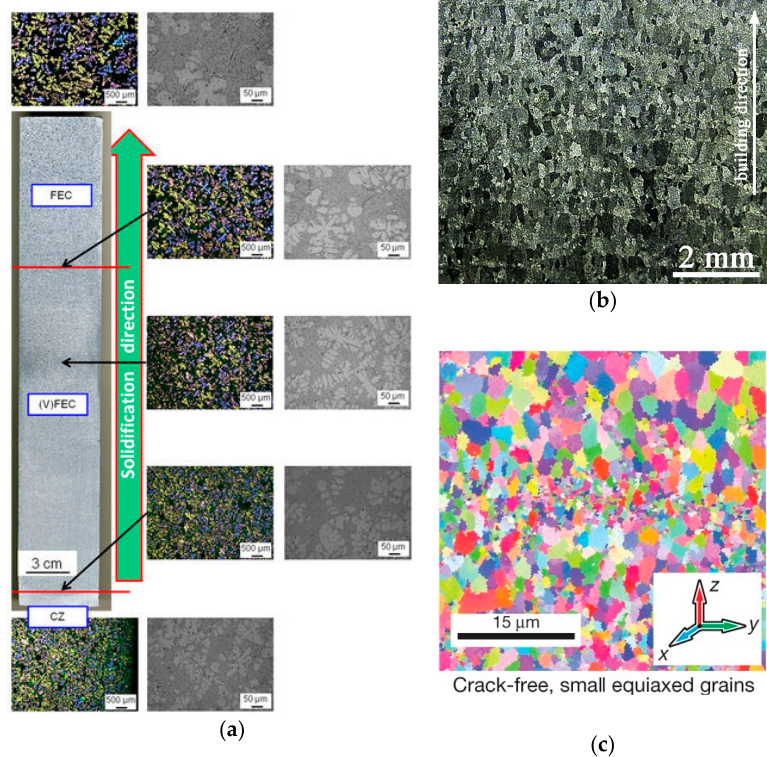
Figure 3. ( a ) Microstructure of the directionally solidified Al-10Si alloy with inoculation of Nb-based heterogeneous nuclei. CZ: chilled zone, (V) FEC: (very) fine equiaxed crystals. Adapted from Bolzoni [16]; ( b ) Optical micrographs showing fine near-equiaxed grains on the transverse cross section of the thick-plate titanium component produced by direct energy deposition (DED) at laser power 6 kW, beam diameter 6 mm, beam scan rate 1000 mm/min and mass deposition rate 50 g/min. Adapted from Wang [17]; ( c ) Fine equiaxed grains of selective laser melting (SLM)-processed aluminum alloy in the as-built condition produced with modified powders. Adapted from Martin [18].